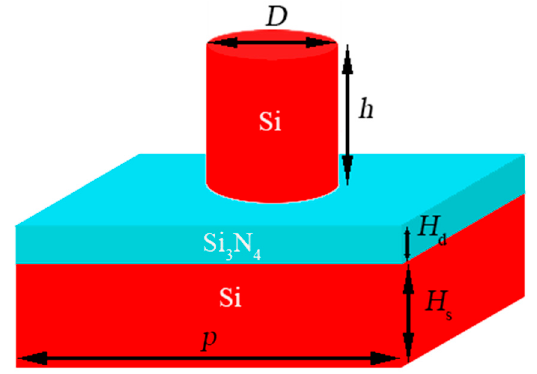
Figure 1. Schematic diagram of the nanostructrue unit cell.